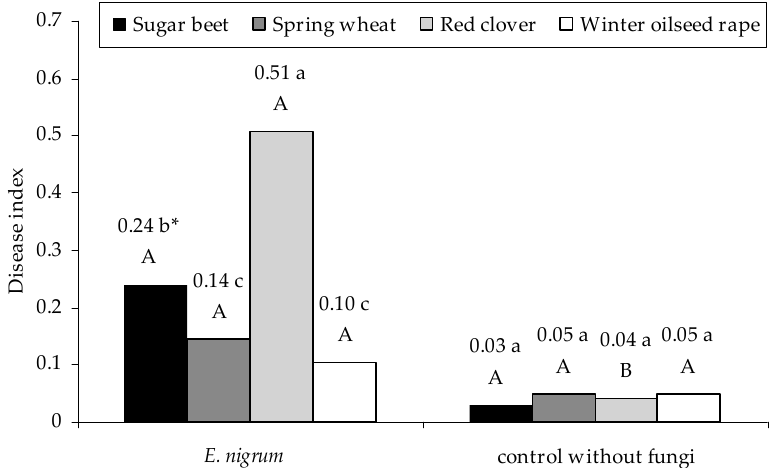
Figure 6. The percentage of seedlings of sugar beet ( B. vulgaris L. ssp. vulgaris ), spring wheat ( T. aestivum L.), red clover ( T. pratense L.), and winter oilseed rape ( B. napus L.) colonized by 18 strains of E. nigrum . Means followed by the same letter (*) are not statistically di ff erent at the α ≤ 0.01 level, according to the Tukey HSD test. Small letters indicate the di ff erences in percentage of colonization of a given seedling species between E. nigrum strains and the control group. Capital letters indicate the di ff erences in percentage of colonization of seedlings within E. nigrum strains and the control group.